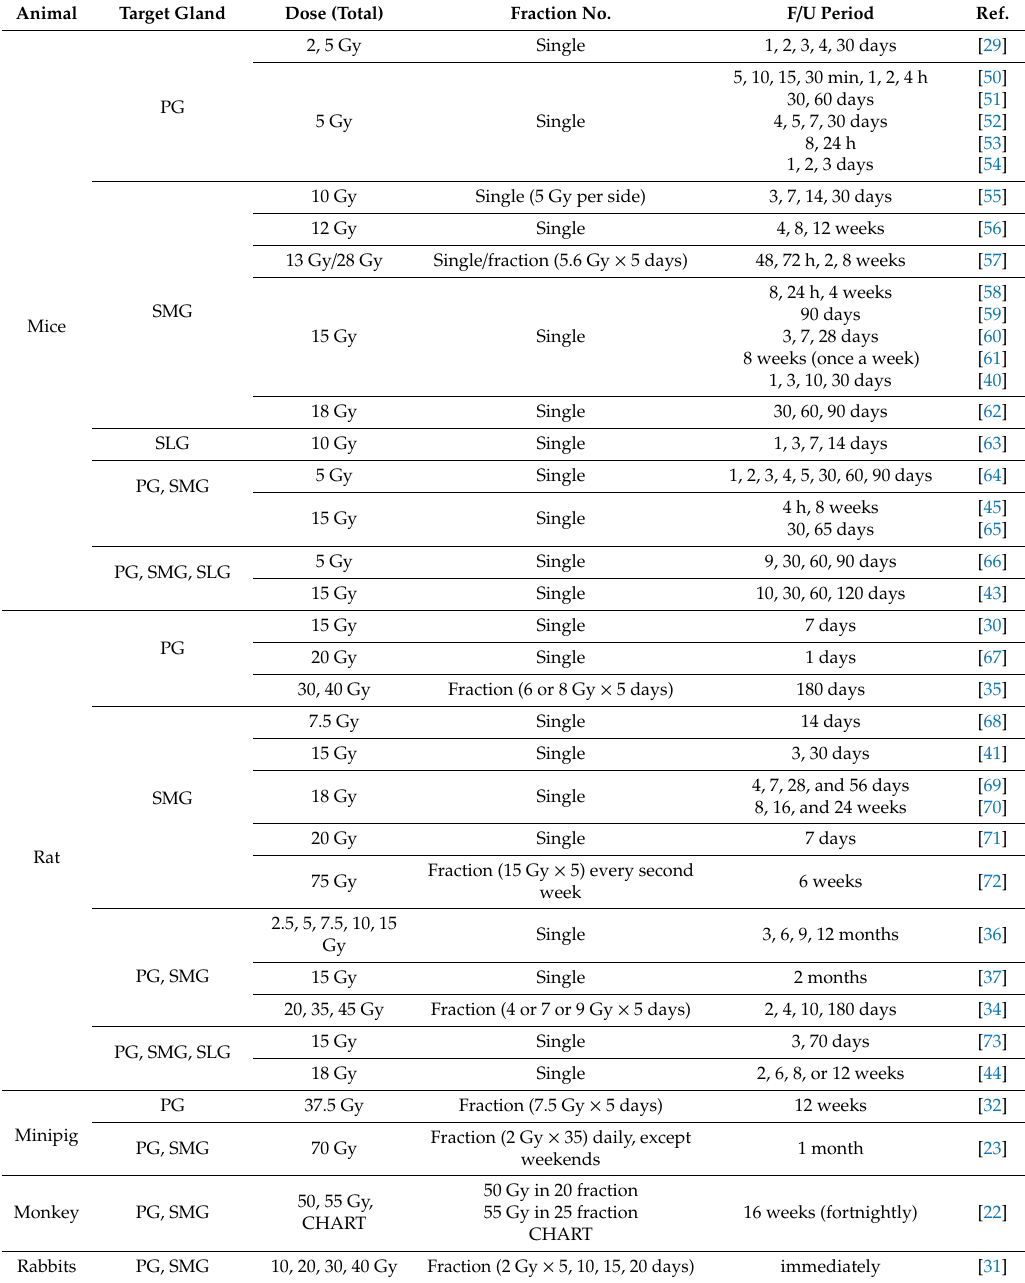
Table 2. Irradiation protocols used in previous